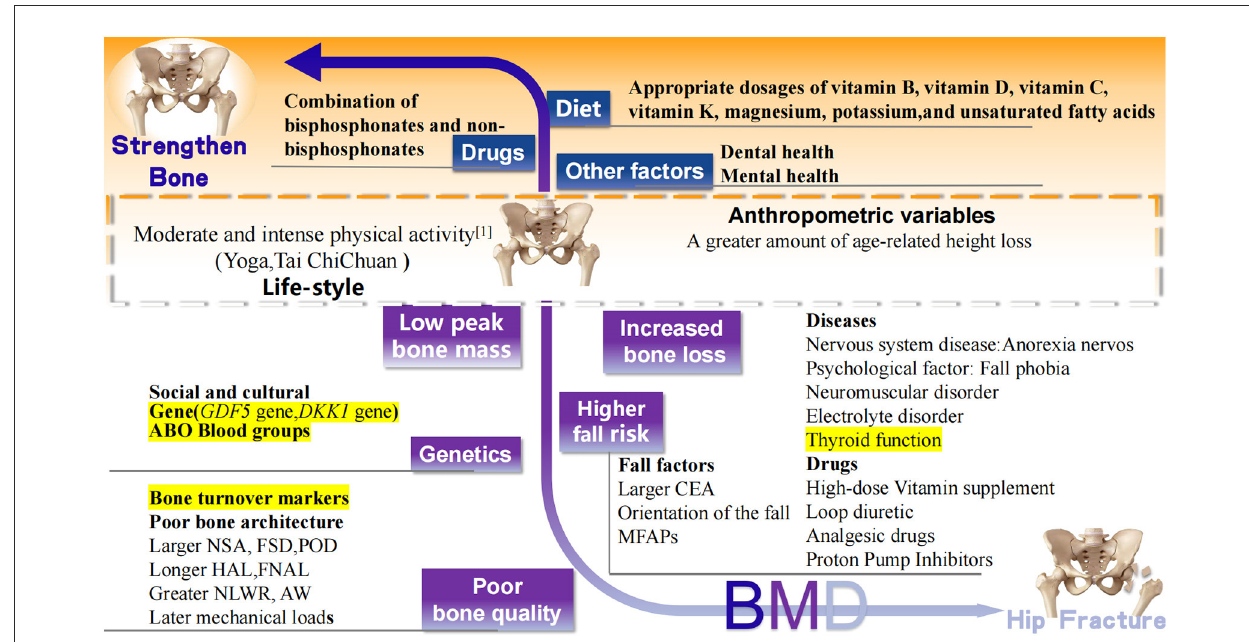
FIGURE3 Recently confirmed factors associated with hip fracture. Black words: well accepted risk (white background), protective (orange background) factors, and controversial (yellow background) factors related to hip fracture. BMD, bone mineral density; MFAPs, meteorological factors and air pollutants; GDF5, Growth differentiation factor 5; DKK1, Dickkopf 1 gene; CEA, central edge angle; NSK, neck shaft angle; FSD, femoral shaft diameter; POR, pelvic outer diameter; HAL, length of hip axis; FNAL, femoral neck axial length; NLWR, neck length-width ratio; AW, acetabular